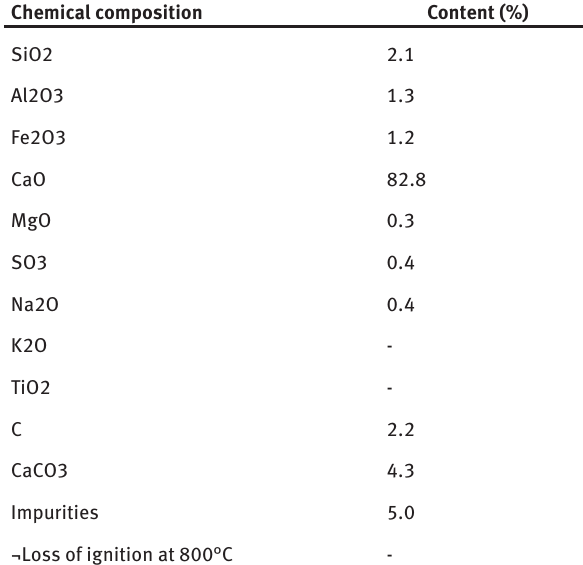
Table 7: Chemical composition of lime